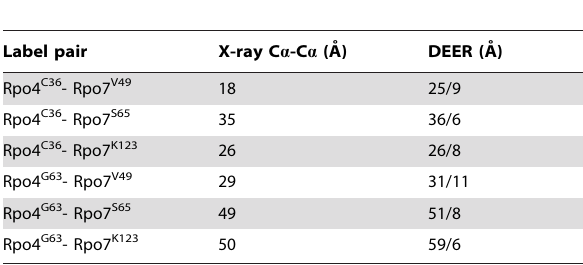
Table 2. Experimental DEER distances compared to distances derived from the crystal